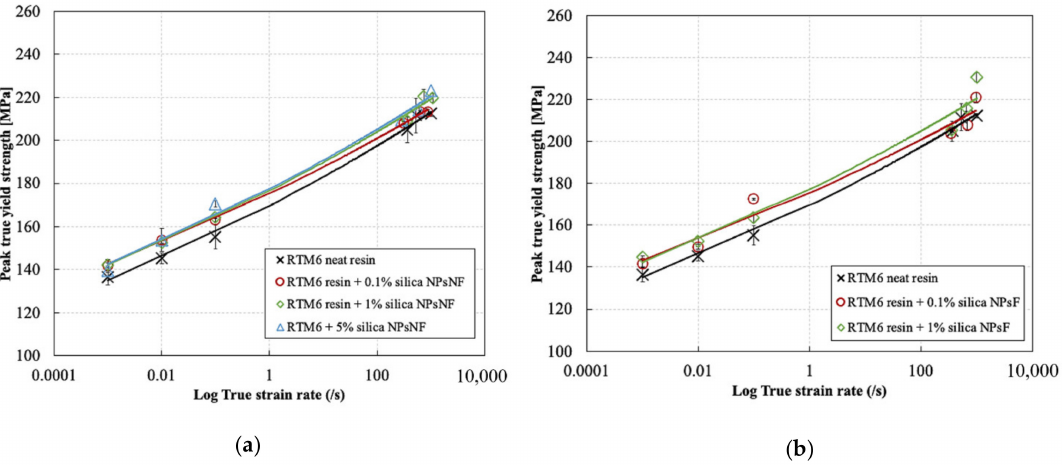
Figure 11. Effect of strain rate on the compressive true peak yield strength for the silica nanoparticle-filled epoxy at different particle weight contents and functionalization conditions: ( a ) non-functionalized and ( b )